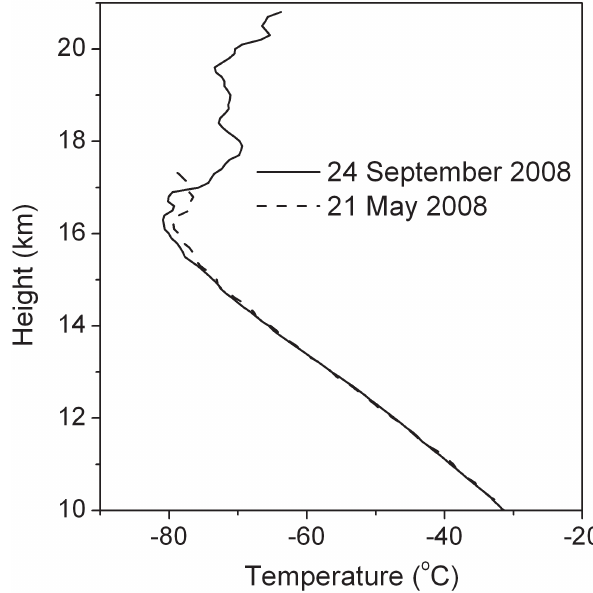
Fig. 4. Vertical profiles of temperature obtained from radioson- des, launched from Gadanki (at 15:00LT on 21 May 2008 and at 17:00LT on 24 September 2008). The cold point tropopause can be seen around 16.3km.